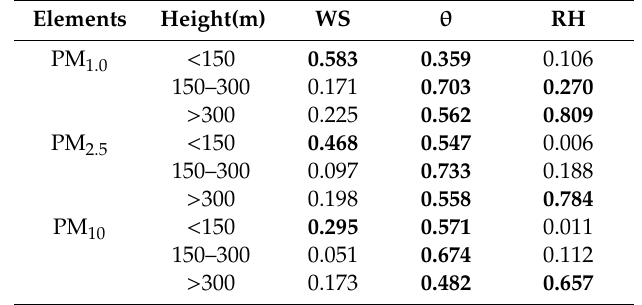
Table 4. Correlation coe ffi cients between the PM 1.0 , PM 2.5 , and PM 10 concentrations and the various meteorological parameters at di ff erent heights above Xiaotang (bold values represent those that passed the 95% significance